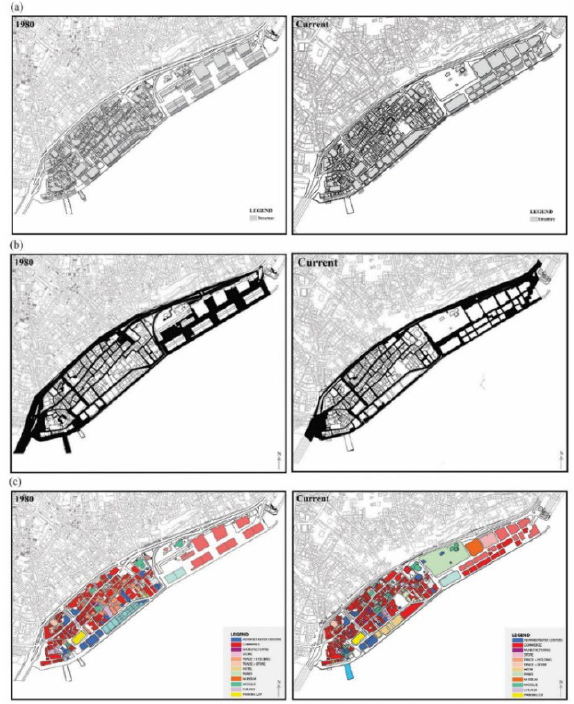
Figure 9 Maps of the area in 1980 (left) and 2020 (right): (a) spatial change; (b) street pattern; (c) land use.